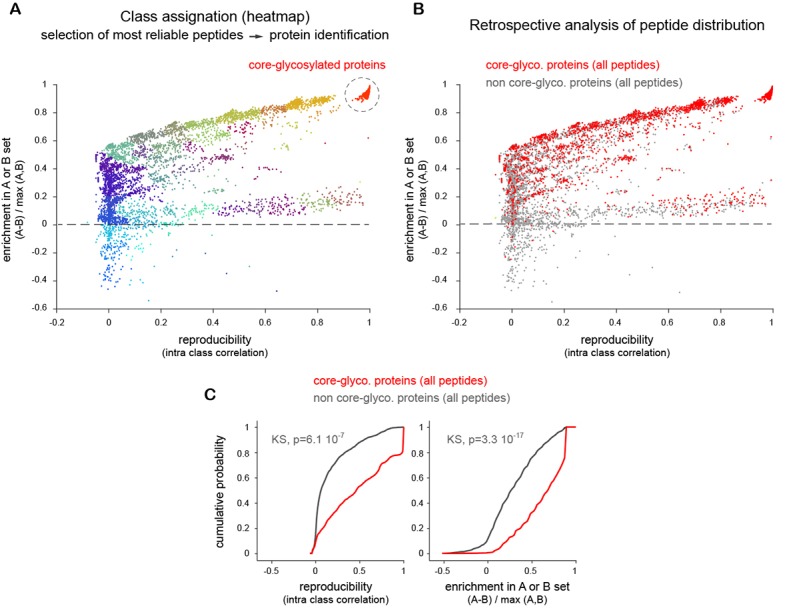
Evaluation of mass spectrometry data part 1.Enrichment of peptides from proteins in the A (w/o EndoH) and B (w EndoH) sets as a function of repeatability across experiments and technical replicates (see Materials and methods). (A) Identification of high confidence core-glycosylated proteins. Plot of normalized peptide intensities (label free quantification) in samples without ('A', target core-glycosylated) or with prior treatment with Endo H ('B', background) as a function of detection reproducibility (intra class correlation) across multiple technical replicates and independent experiments. Shown in colors are the various groups detected after hierarchical clustering. Note the clear separation of peptides close to y=0 (equally distributed in A and B) and y=1 (only found in A) as reproducibility increases. Shown in red are peptides with the highest enrichment and reproducibility which were used to identify 'core-glycosylated' proteins. (B–C) Retrospective analysis of all the peptides originating from proteins identified in high-confidence core-glycosylated group. (B) Core-glycosylated protein peptides (red) versus all the other peptides (grey), plotted as in A. (C) Distribution (cumulative probability) of core-glycosylated protein peptides (red) versus all the other peptides (grey) showing the more reliable occurrence of core-glycosylated proteins and their sensitivity to EndoH. KS, Kolmogorov-Smirnov’s test.